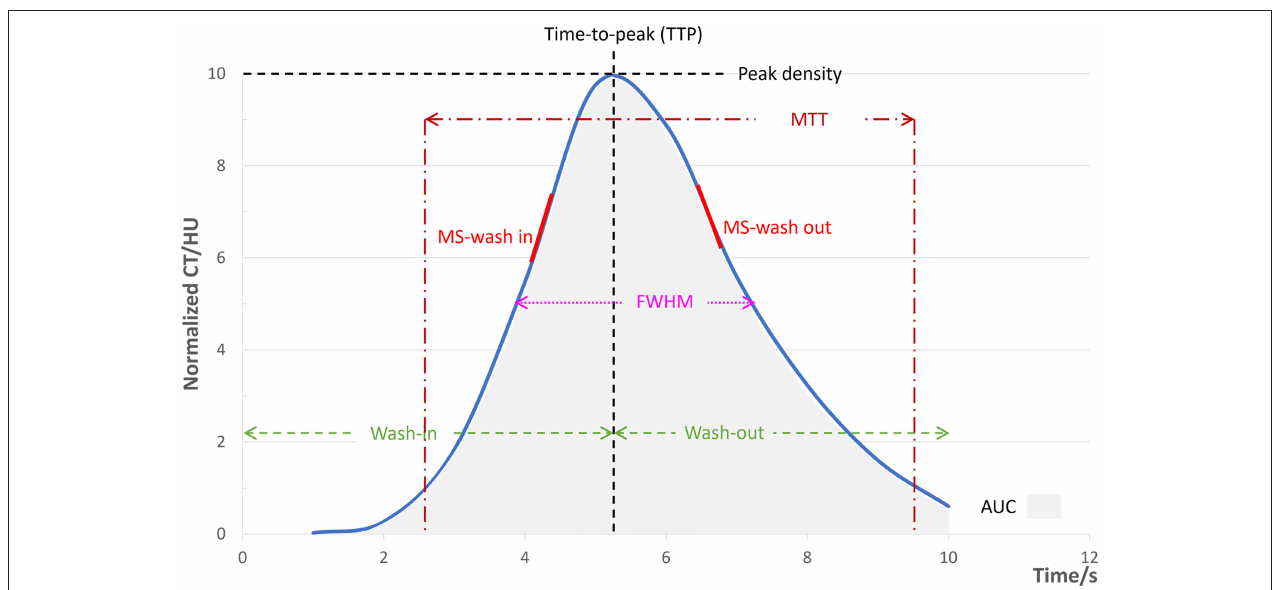
FIGURE 2 | Illustration diagram of each parameter. The simulated TDC according to the time-contrast agent intensity curve by the Matlab software and the hemodynamic parameters calculated from the TDC. TDC, time-density curve; FWHM, full width at half maximum. MTT, mean transit time; MS, maximal slope; AUC, area under